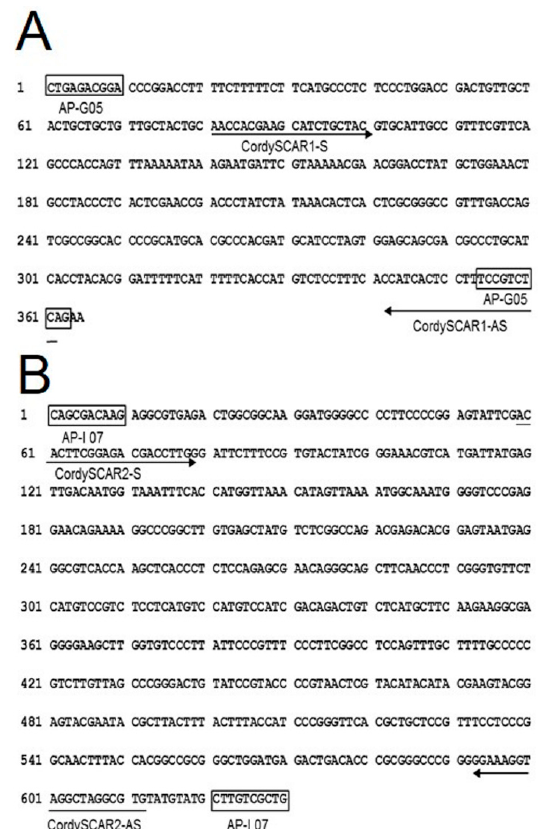
Figure 4. Nucleotide sequence of the RAPD amplicon. ( A ) DNA sequence of the PCR product generated from AP-G 05. RAPD primers (a pair of AP-G 05) and SCAR primers (CordySCAR1-S and CordySCAR1-AS) were indicated; ( B ) DNA sequence of the PCR product generated from AP-1 07. RAPD primers (a pair of AP-I 07) and SCAR primers (CordySCAR2-S and CordySCAR2-AS) were indicated.